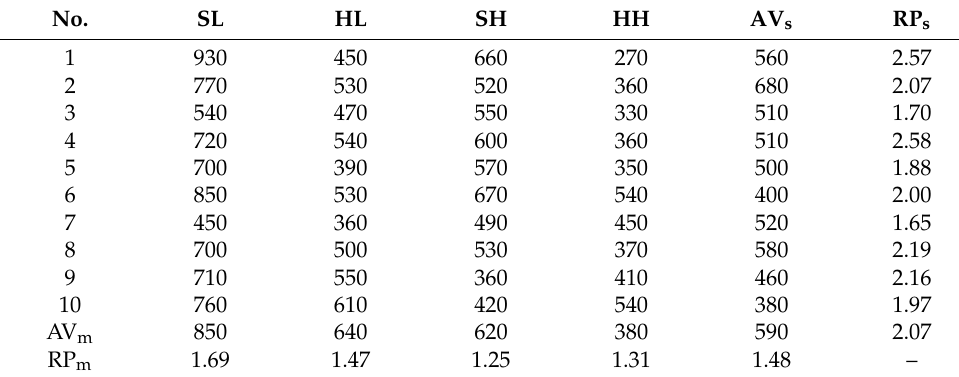
Table 5. A comparison of averages, ranges, and loading